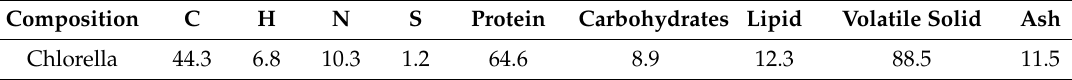
Table 3. Elemental and composition analysis of microalgae (moisture free basis, % by weight).